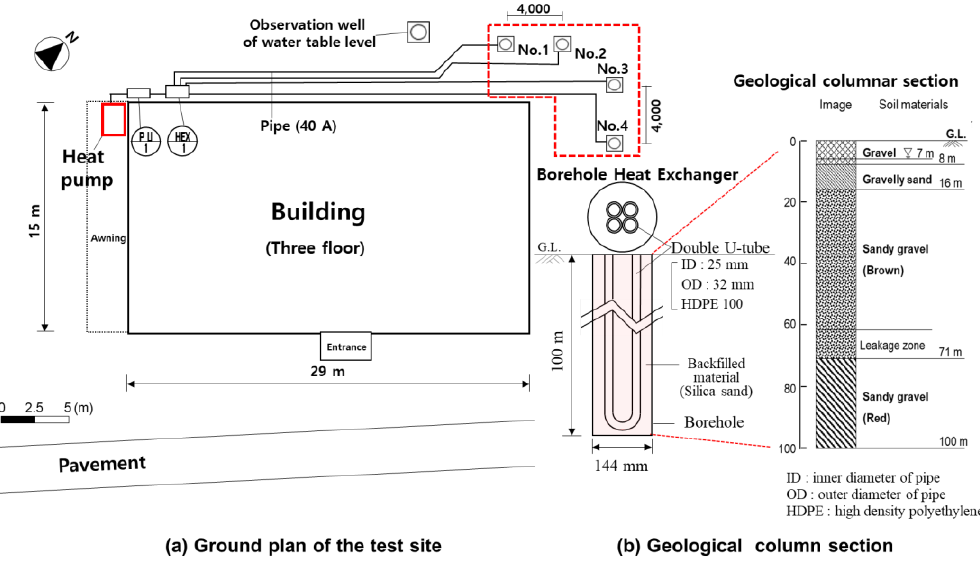
Figure 1. Site description: ( a ) the ground plan of the test site; ( b ) the geological column section.